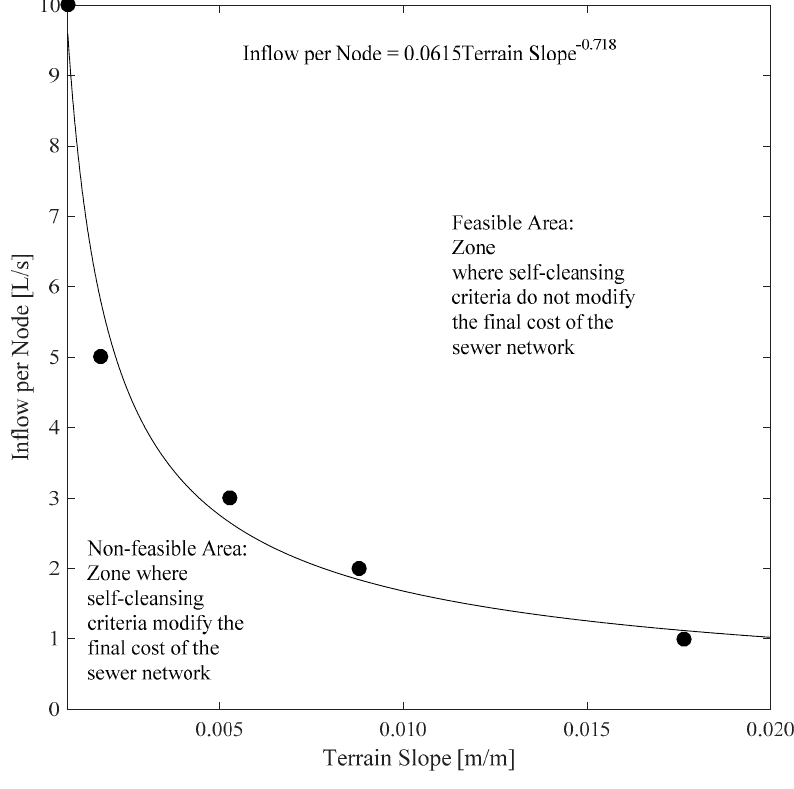
Figure 4. Self-cleansing limits in sewer systems.